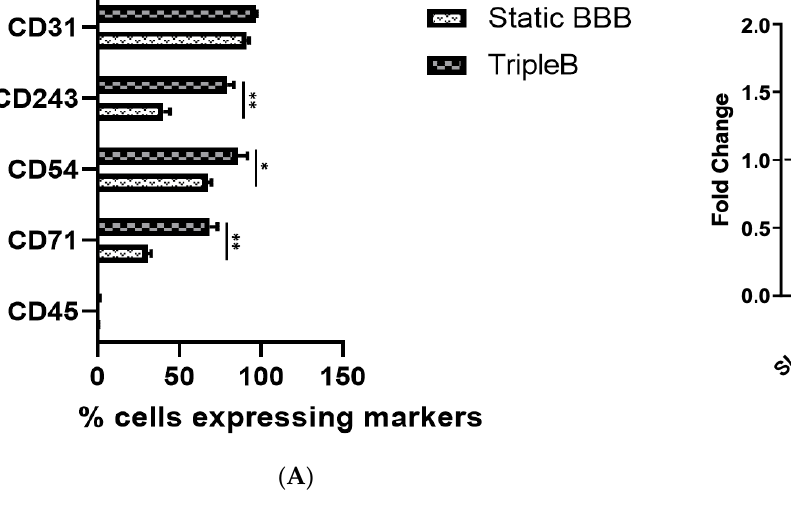
Figure 7. TripleB cultured barriers demonstrate a much higher expression of P-glycoprotein along with other endothelial-cell-specific markers when compared to transwell-cultured barriers. Phenotypic differences in the static and dynamic cultured BBB ( A ) BBB cultured in the TripleB slides showed a significantly higher expression of EC-specific markers compared with the static in vitro BBB. ( B ) mRNA encoding the tight junction proteins SLC2A1, TJP1, OCLDN1 and CLDN5 was found to be significantly upregulated in TripleB cultures as compared to the static BBB cultures (n = 4, * p ≤ 0.05; ** p ≤ 0.01).